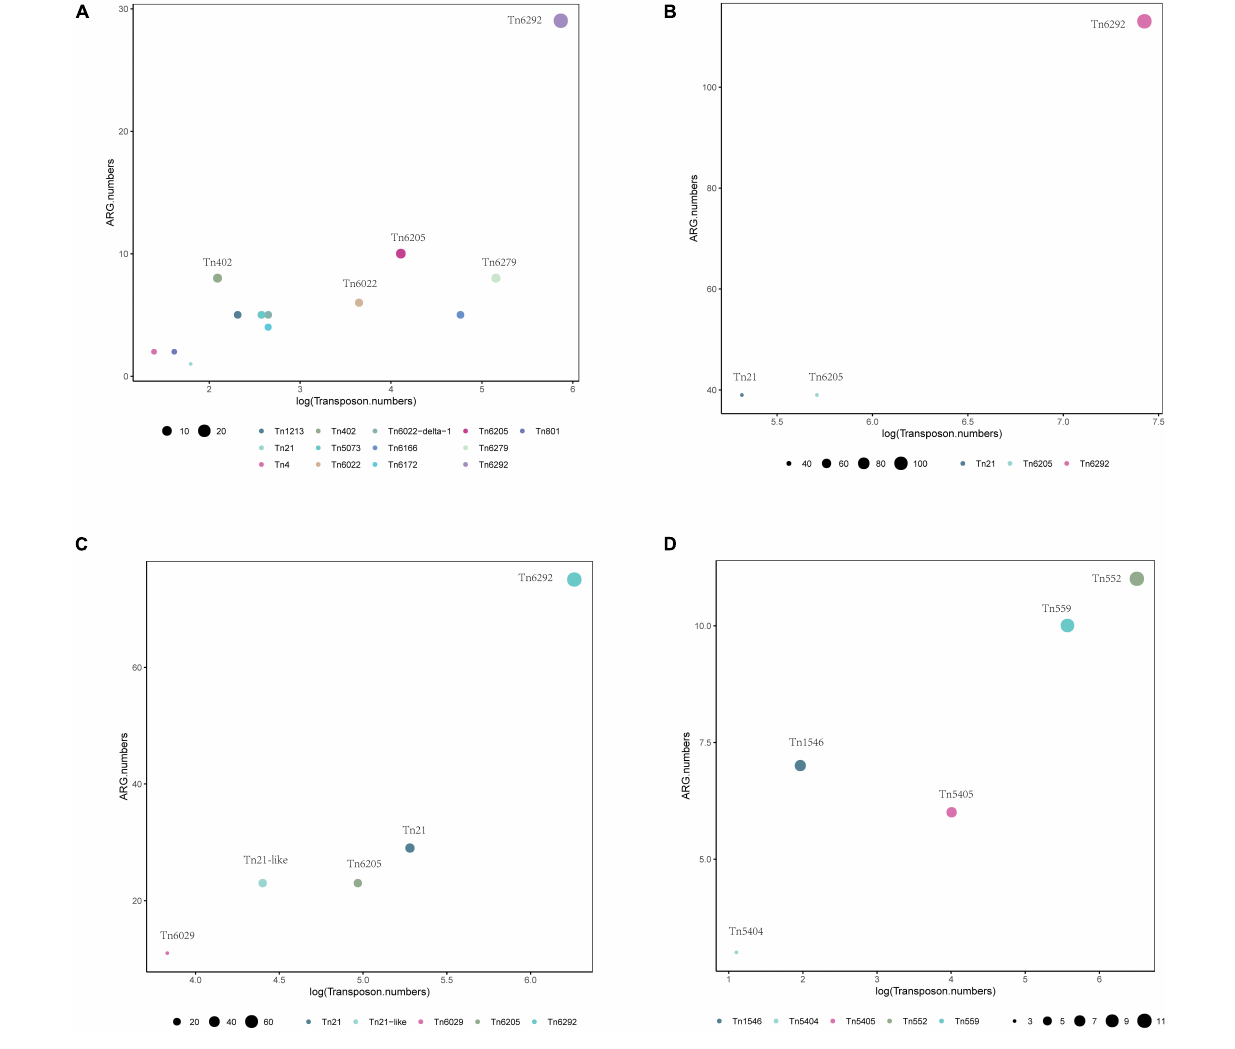
FIGURE 7 | Distribution of transposons with statistically significant association with different types of ARGs within a 10 kb distance. Different colors show various transposons, the size of the circles indicate the presence of their associated ARGs in (A) A. baumannii , (B) E. coli , (C) S. enterica, and (D) S. aureus